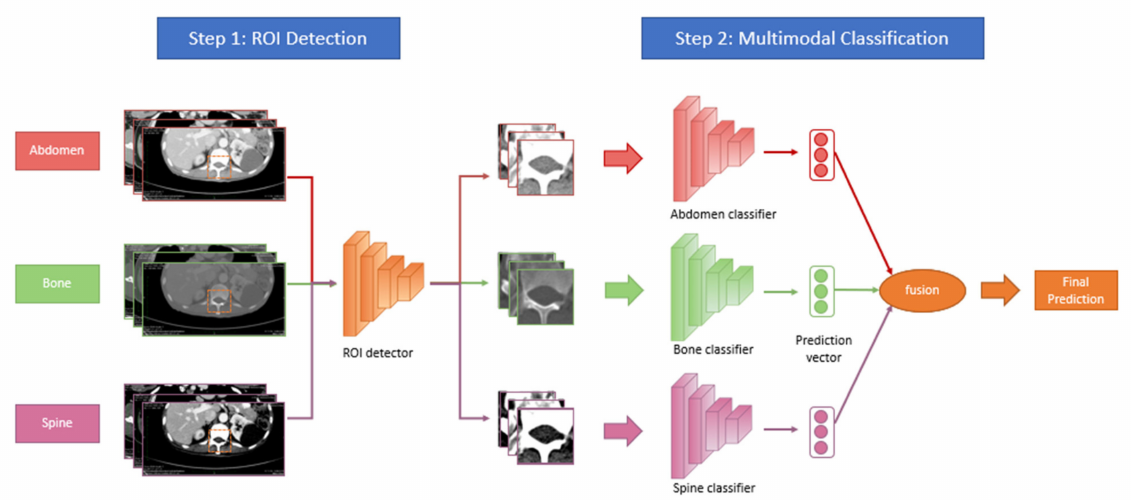
Figure 3. Overview of the developed deep learning pipeline. The developed deep learning pipeline takes input images with information from three different windows. For the first step, a region of interest (ROI) detector is applied to all images of the three windows. In the second step, a window- specific classifier is applied to calculate the prediction probability for each windowed image. We have developed both a separated window learning (SWL) method and a combined window learning (CWL) method. In the separated window learning (SWL) method, three separate networks are trained for the information from three different windows. In the combined window learning (CWL) method, a single network with window-specific batch normalization layers is trained on all windowed images to reduce the memory size. Multimodal fusion techniques, specifically average fusion and max fusion, are applied at the prediction probability vectors to aggregate all the complementary information from images of different windows for the final